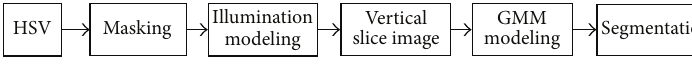
Figure 1: HSV segmentation algorithm.